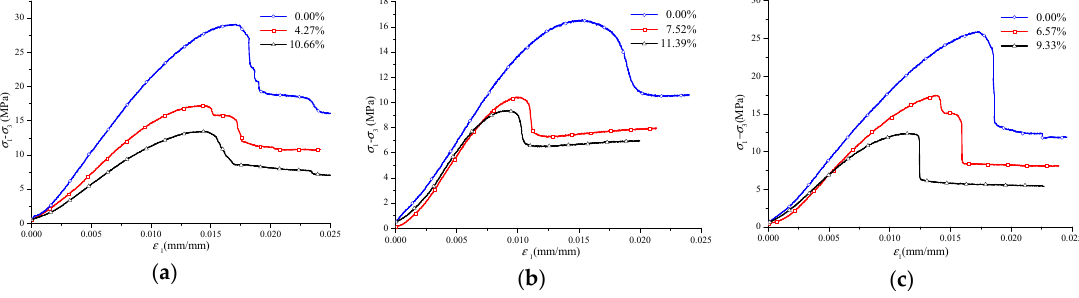
Figure 6. Stress-strain behavior of rock samples with different moisture contents. ( a ) Mudstone, ( b ) sandstone, ( c ) sandy mudstone.